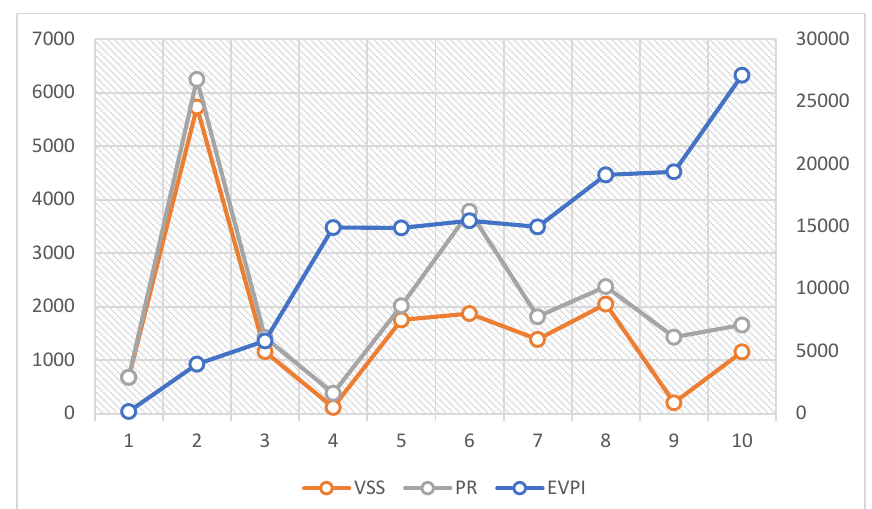
Fig. 11. The value of EVPI, VSS, and PR in different